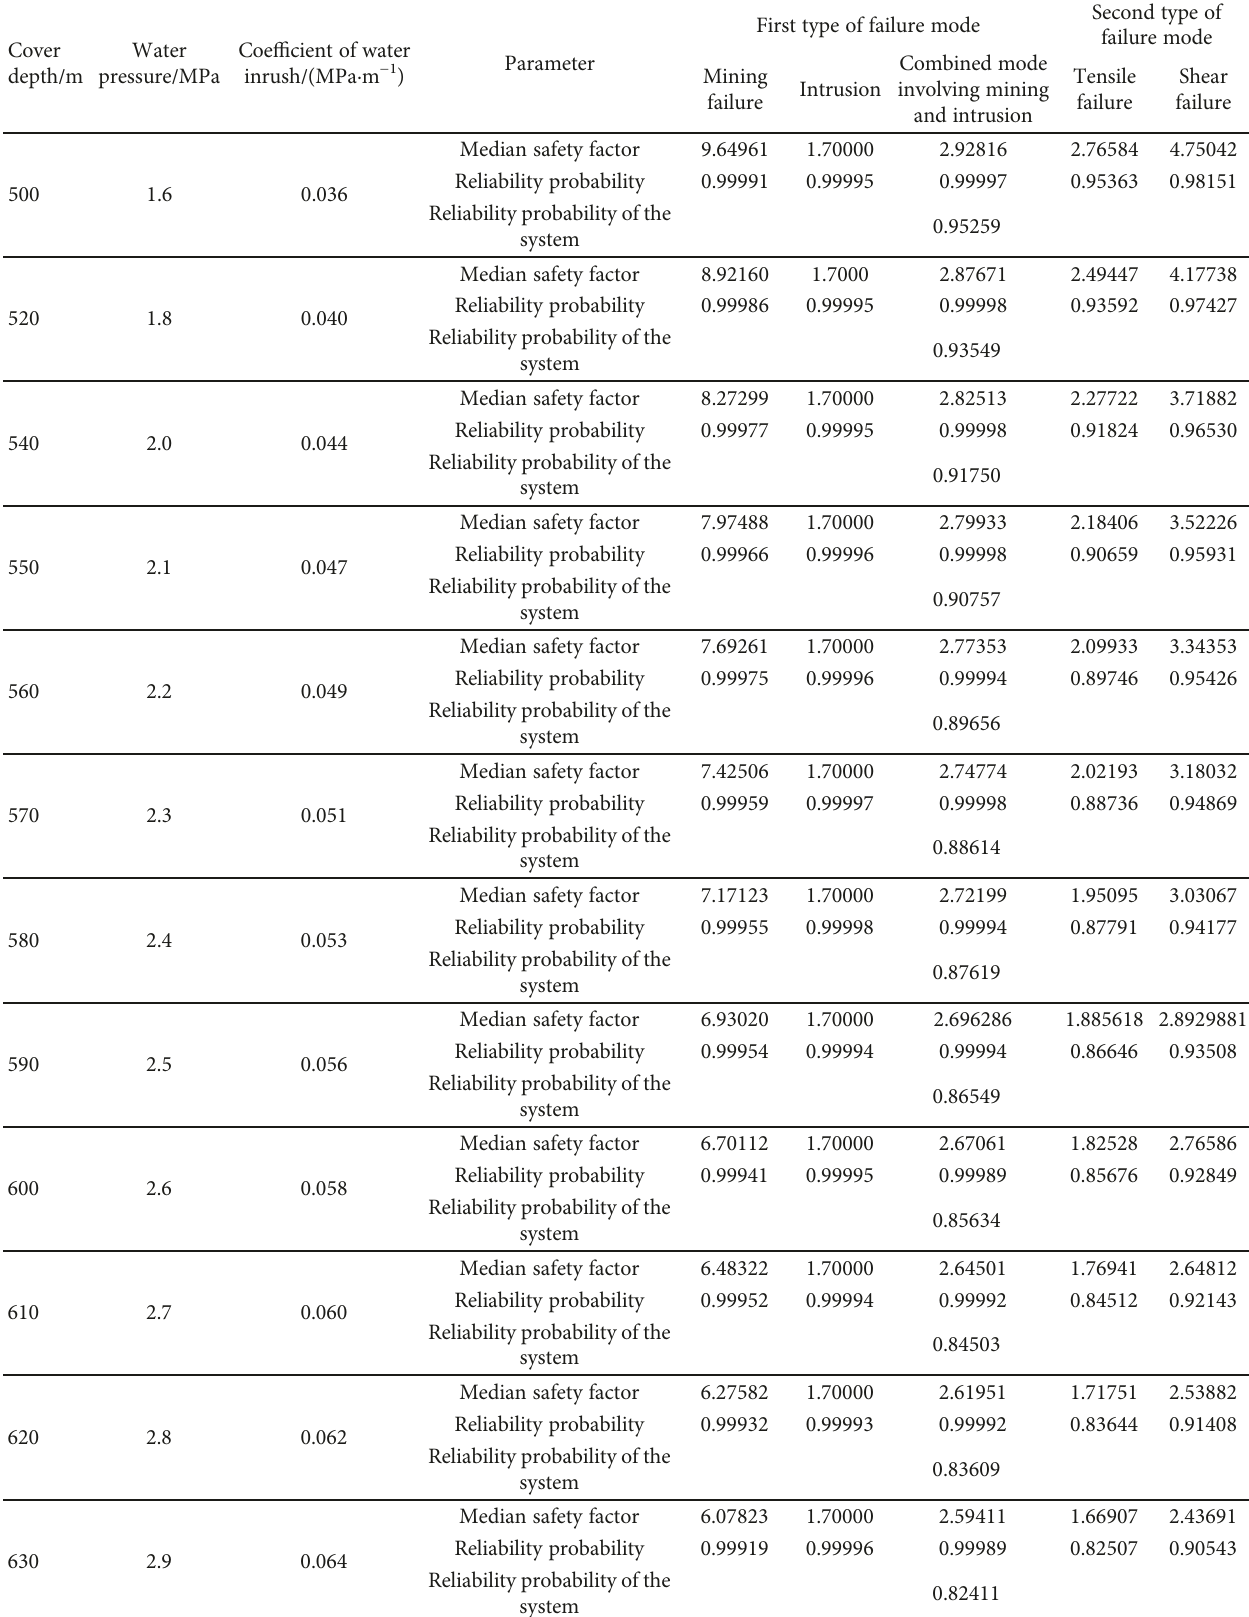
Table 4: Calculation results of reliability probability of the water-resistant fl oor ’ s